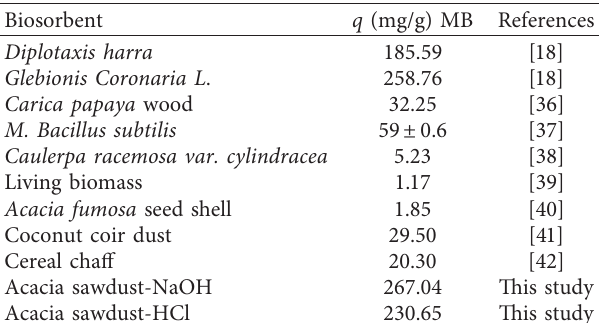
Table 4: Comparison of maximum biosorption capacity of A- NaOH and A-HCl for MB with corresponding low-cost